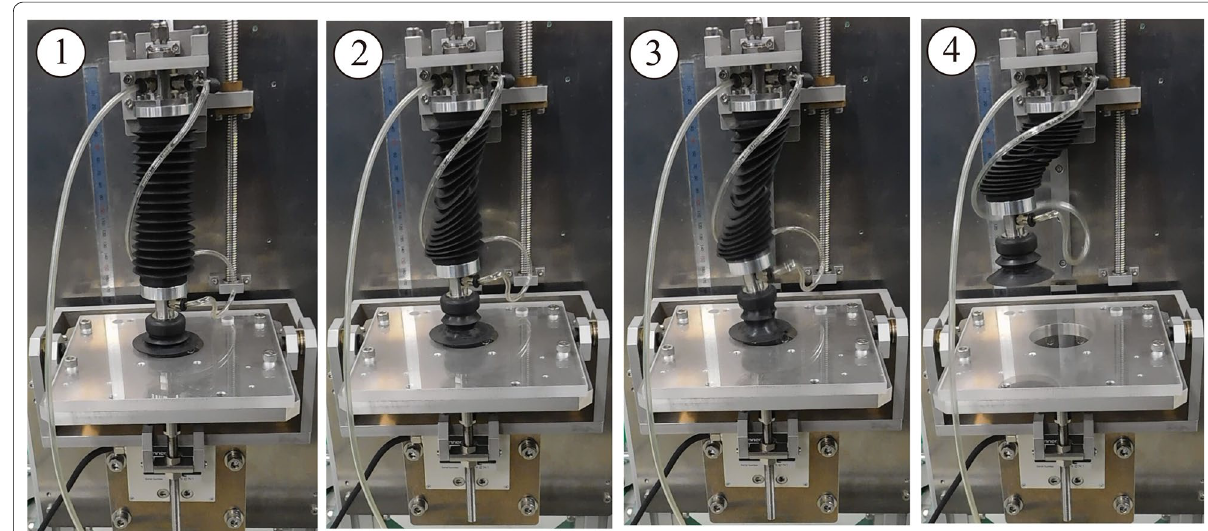
Fig. 39 Deformation process of bellows pneumatic actuator